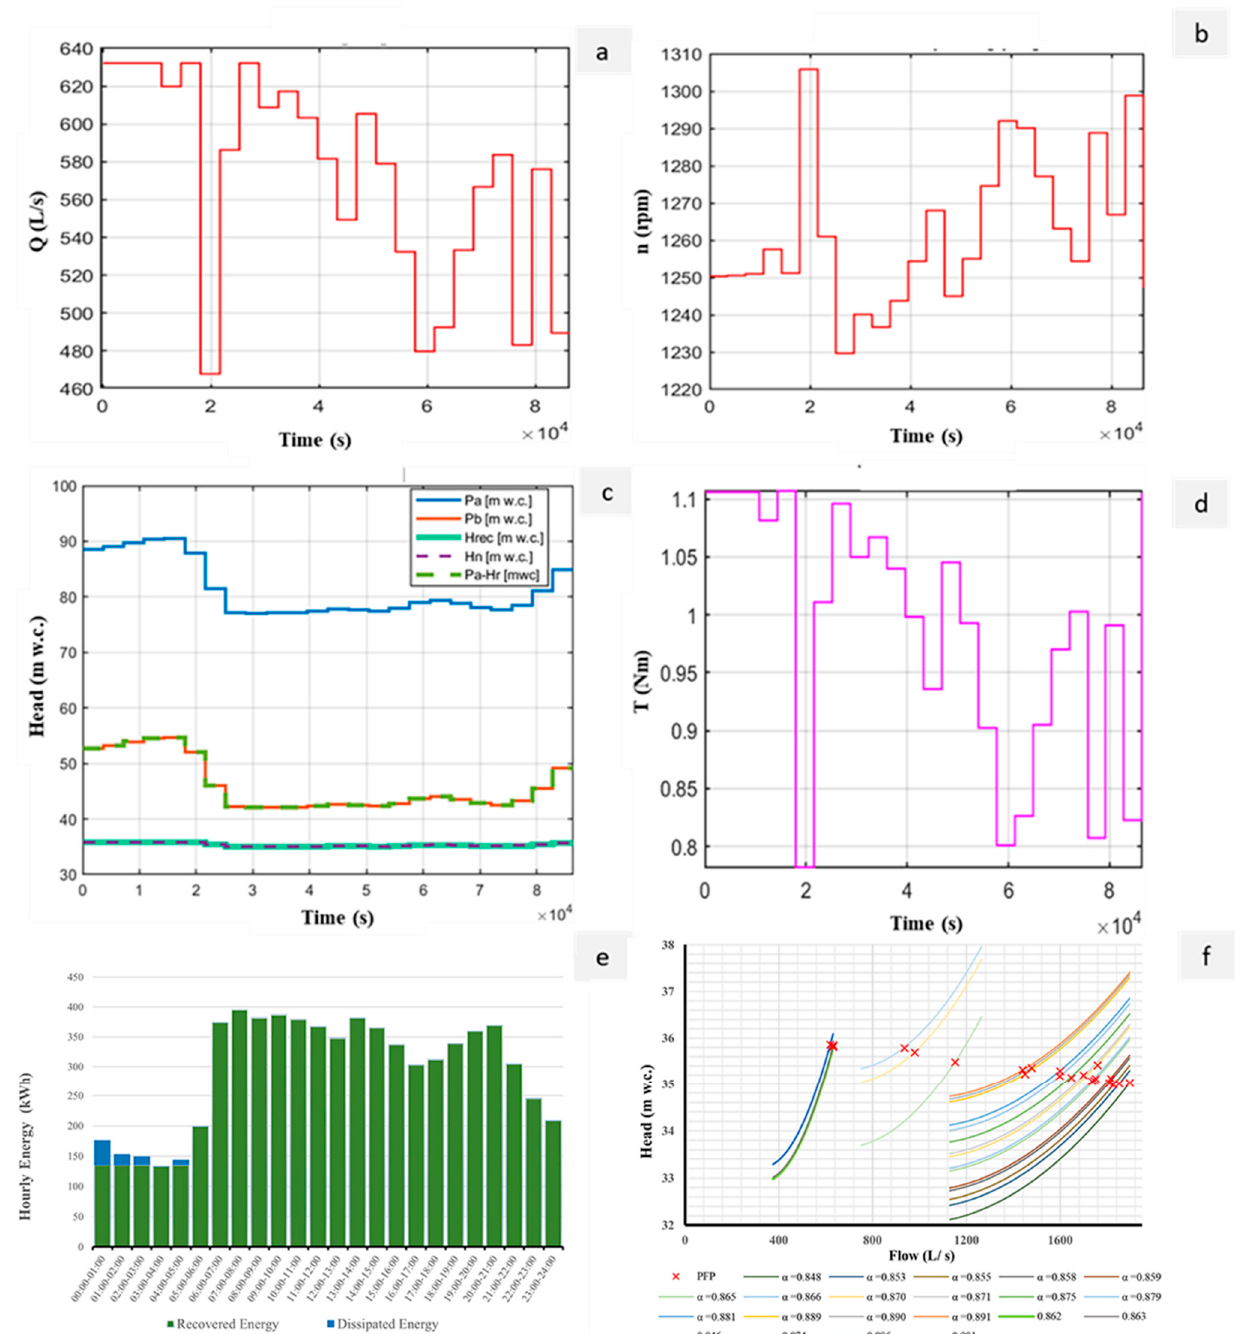
Figure 5. ( a ) Flow over time; ( b ) rotational speed of the machine over time; ( c ) pressures and Head over time; ( d ) torque over time; ( e ) hourly energy; ( f ) regulation of the recovery system.